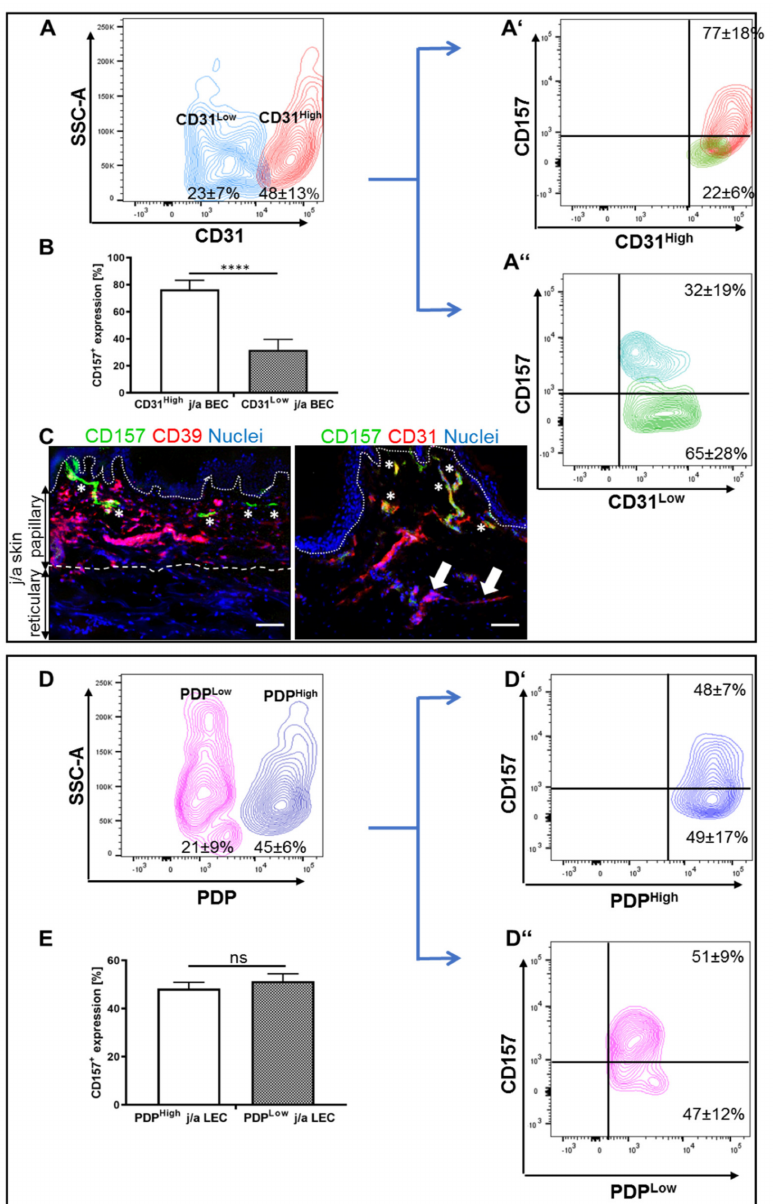
Figure 2. CD157 expression on CD31 High/Low and podoplanin High/Low expressing freshly isolated HDMEC ( A , B ) The whole HDMEC population was separated into two distinct fractions: CD31 High and CD31 Low expressing subpopulations. ( A (cid:48) , A” , B ) Representative FACS dot plots ( A , A” ) and quantification ( B ) of freshly isolated and separated cells. Whereas CD31 High HDMEC showed enhanced expression of CD157 + , CD31 Low subpopulation showed a reduced expression of CD157 (**** p = 0.0010 extremely significant; n = 7). ( C ) Immunofluorescence co-staining for CD39, a papillary fibroblast marker (red) and CD157 (green) in j/a skin showing the presence of CD157 expressing capillaries (asterisks) in CD39-positive papillary dermis ( C ). Further, co-staining for CD31 (red) and CD157 (green) demonstrates CD157 + CD31 High capillaries (asterisks) in the upper, papillary dermis, whereas CD157 - CD31 Low capillaries (arrows) are predominantly located in lower, reticular dermal parts. ( D , D” ) HDMECs show distinct separation into PDP High and PDP Low expressing subpopulations. ( E ) Quantification of CD157 expression on PDP High and PDP Low HDMEC revealed no statistically significant differences between those two subpopulations ( p = 0.530, ns; n = 7). Dotted lines delineate the dermo–epidermal junction. Dashed lines separate the papillary and reticular dermis. Statistical tests were performed using two-way